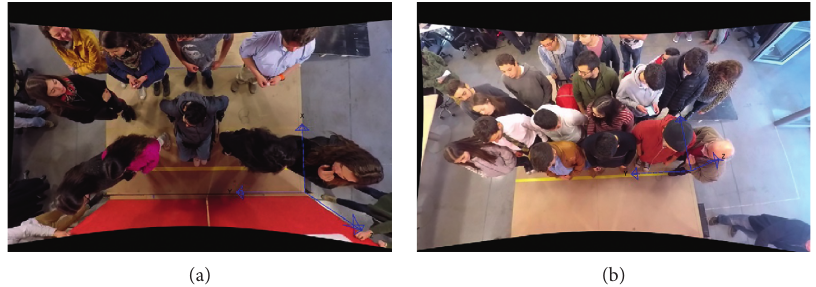
Figure 4: Preferential waiting zone scenarios simulated in the laboratory.